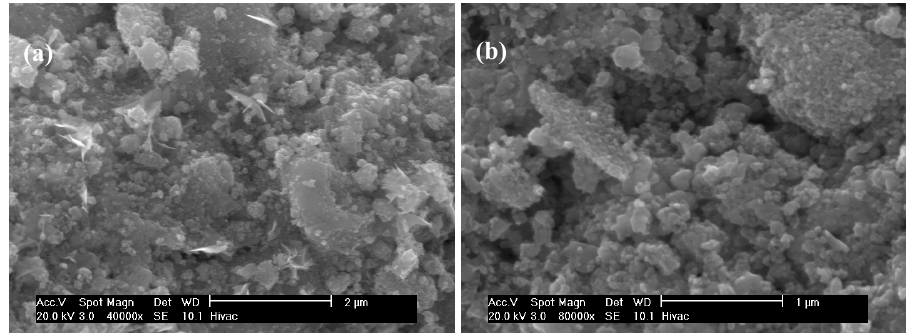
Figure 2. SEM images ( a – c ) and EDX spectrum ( d ) for products from experiment